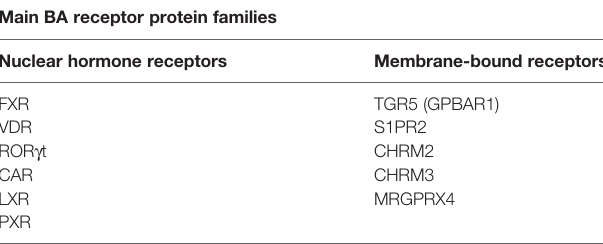
TABLE 1 | Nuclear and membrane receptors of